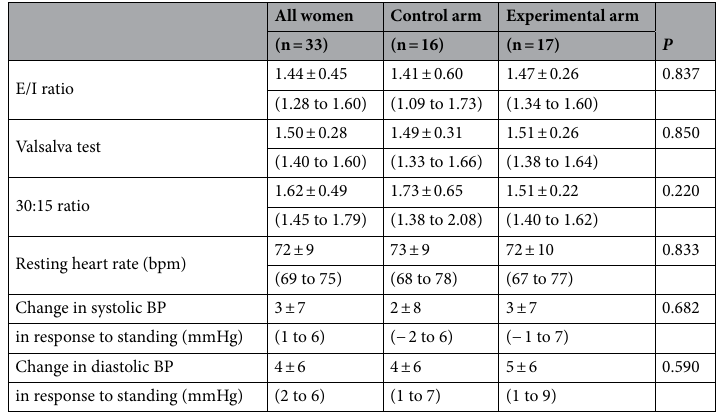
Table 2. Cardiovascular autonomic function tests values at baseline. Continuous and discrete variables are mean ± SD. Figures below those statistics denote 95% confidence intervals (lower limit to upper limit). Comparisons between both arms of the study were conducted by t